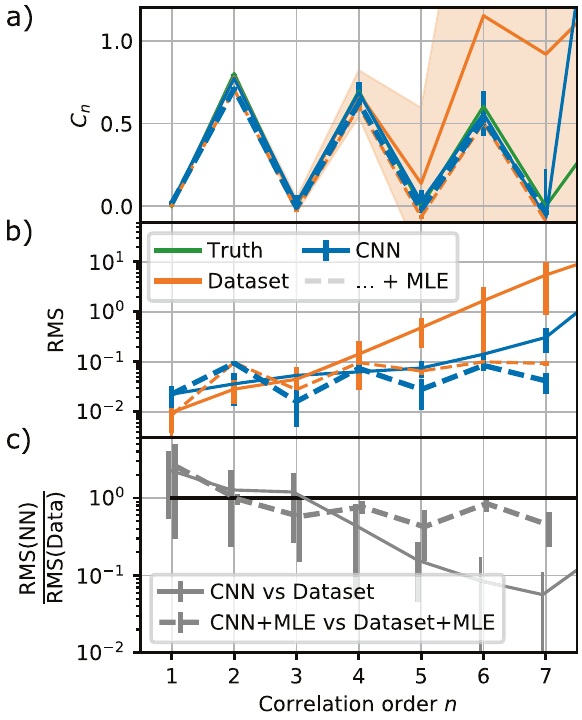
Fig. 4 Tomography of noisy long-range interacting groundstates: NN vs plain data. Evaluating the ARCNN by evaluating observables from Eq. (9) and comparing to those obtained from the plain dataset, on a length 16 ion chain with 3% dephasing noise, J / B = 0.6 and open boundaries, with a dataset size of N s = 10 k. Dashed lines show results of applying local MLE directly to dataset (orange) and to a neural network enhanced dataset (blue). a Observables according to Eq. (9), b residual RMS error, c residual network RMS normalized to dataset RMS. Error bars are standard deviations across multiple independent tomography datasets and neural network training runs with randomly initialized parameters.